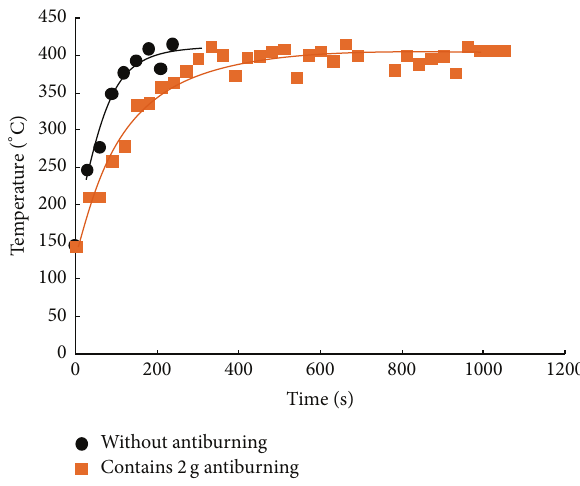
Figure 13: Change in the composite temperature with time using different masses of fire-retardant